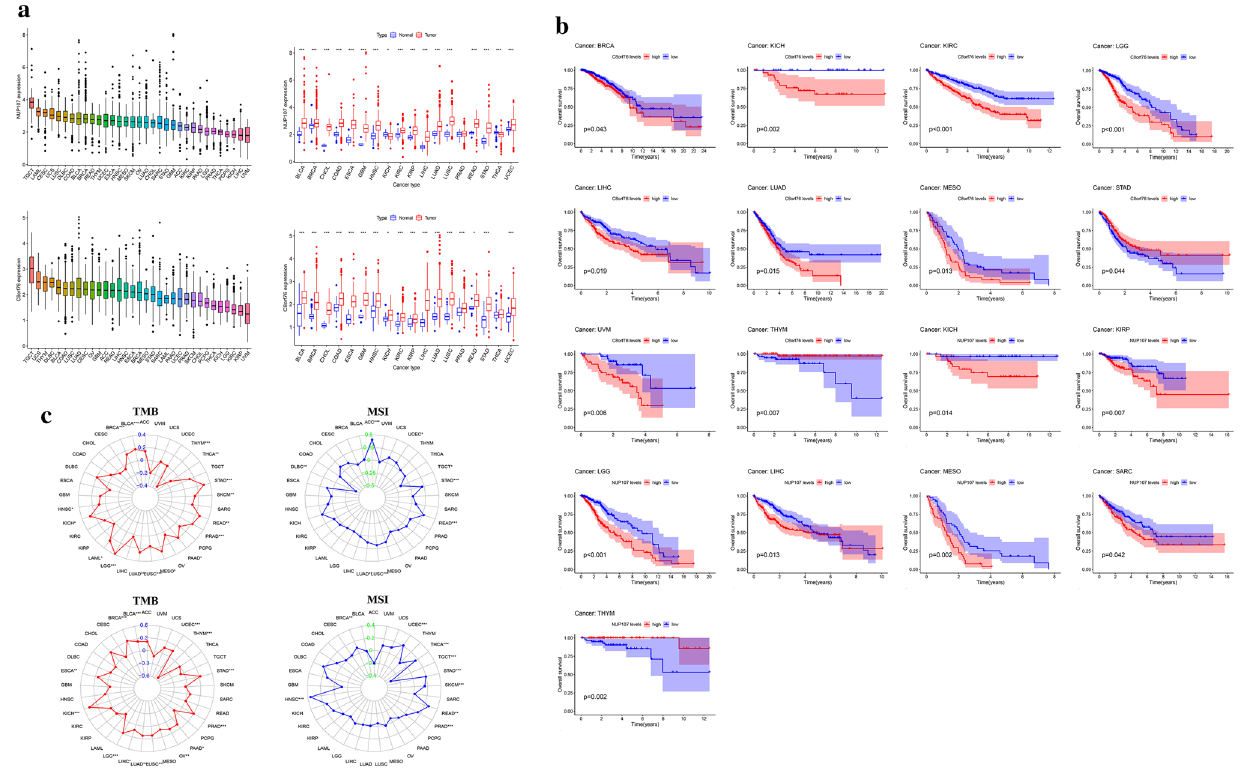
Fig. 10 Expression analysis, survival analysis, TMB, and MSI analysis of NUP107 and C8orf76 in pan-cancers. a Expression level of NUP107 and C8orf76 in pan-cancers. * P < 0.05, ** P < 0.01, *** P < 0.001. b The survival curve of NUP107 and C8orf76 for OS in pan-cancers. c The cor- relation between NUP107 and C8orf76 expression and TMB, and MSI in pan-cancers